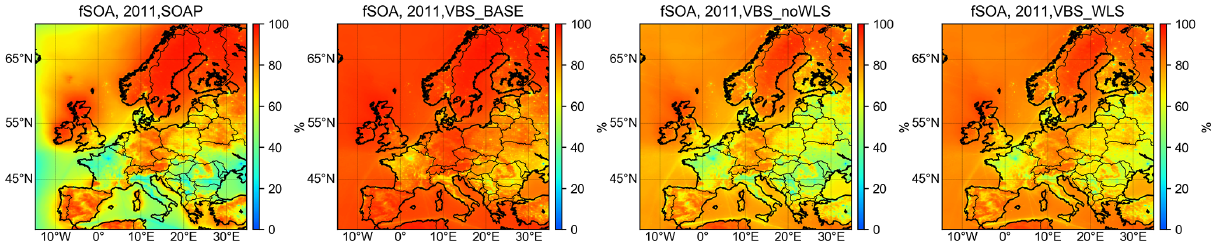
Figure 8. Modeled fractions of annual mean SOA to total OA (fSOA) using different OA schemes. Modeled results for VBS_3POA are very similar to VBS_noWLS and are therefore not shown